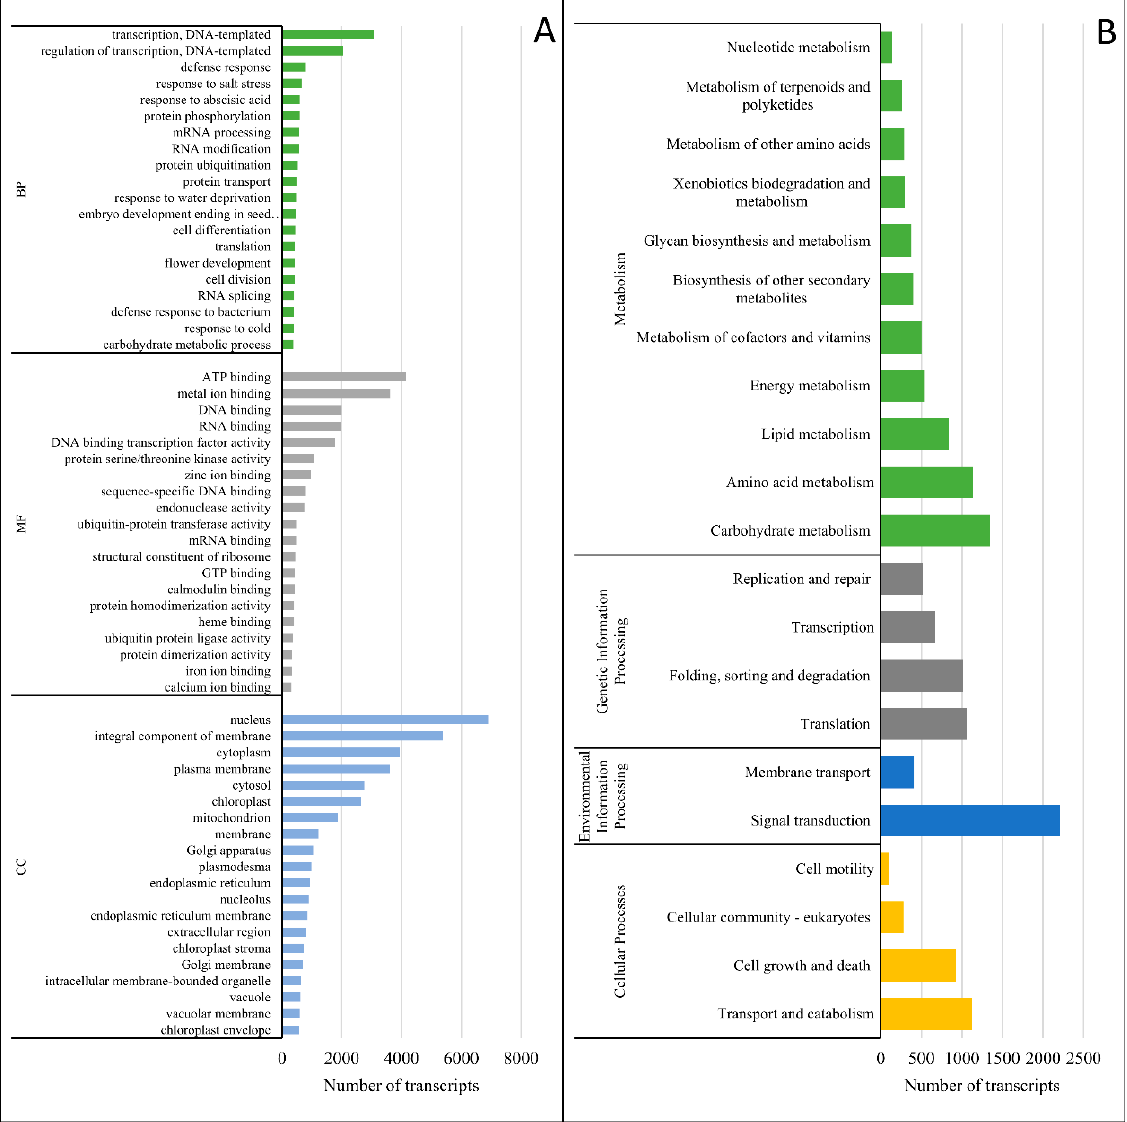
Figure 6. ( A ) Distribution of C. sativus transcripts in the top 20 gene ontology (GO) categories in biological processes (BP), molecular functions (MF), and cellular components (CC). ( B ) Pathway assignment was based on the Kyoto Encyclopedia of Genes and Genomes (KEGG) database. Classification was based on organismal system categories, cellular process categories, environmental information processing categories, genetic information processing categories, and metabolism categories.